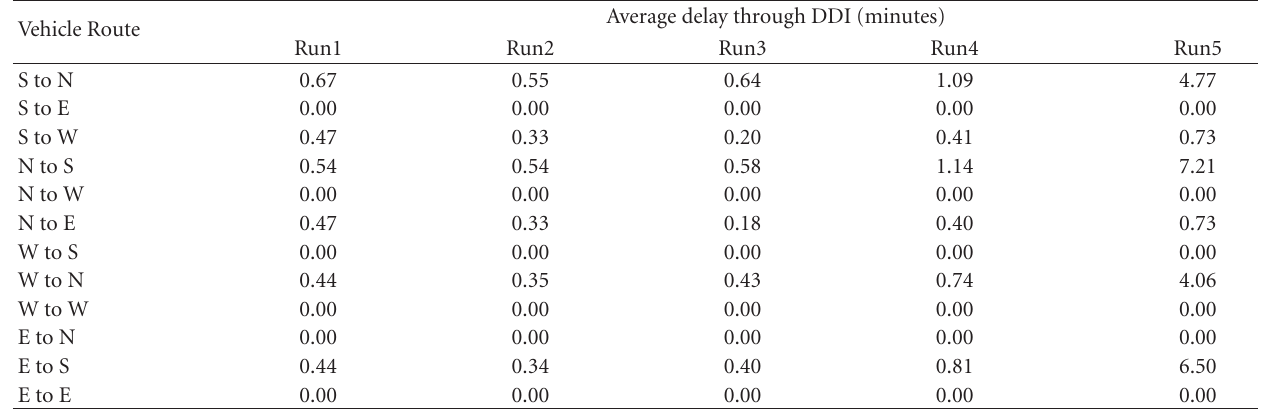
Table 5: Results for Runs2–5—average times through DDI.